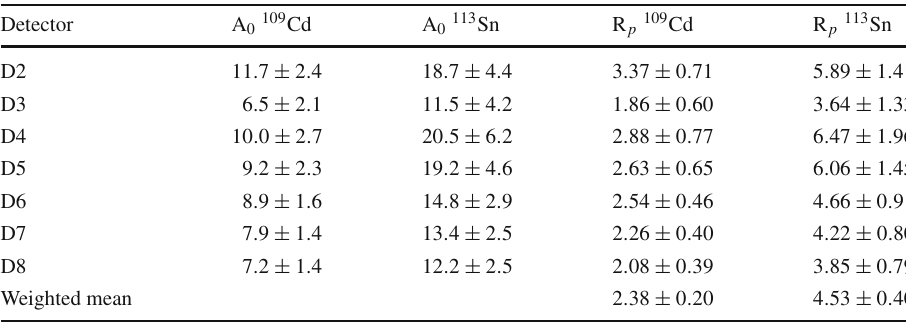
Table 5 Initial activities A 0 and production rates at sea level R p for 113 Sn and 109 Cd deduced from data of several detectors in different ANAIS set-ups. All